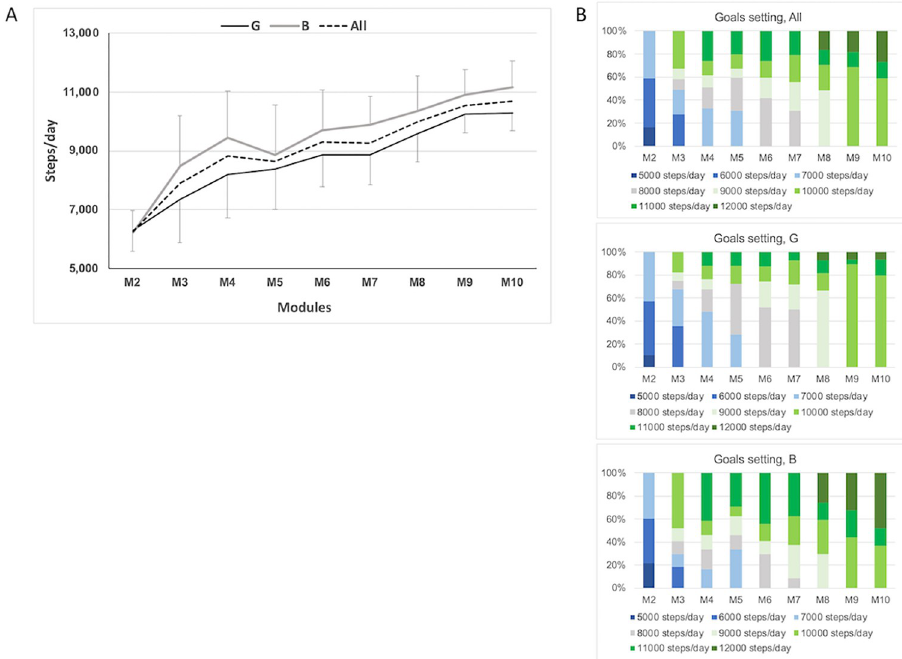
Fig 3. Goals setting. Panel A: average daily steps goals set by adolescents over the course of the program for each module. Goals increased from module 2 to module 10 (Wilks’ Lambda F(8,17) = 91.1, P < 0.001). There was a significant gender effect (F(1, 24) = 4.46, P < 0.05) with boys aiming for higher daily steps goals. Panel B: proportion of adolescents choosing a given step goal for each module. Note: From M6, goals also included a minimum amount of